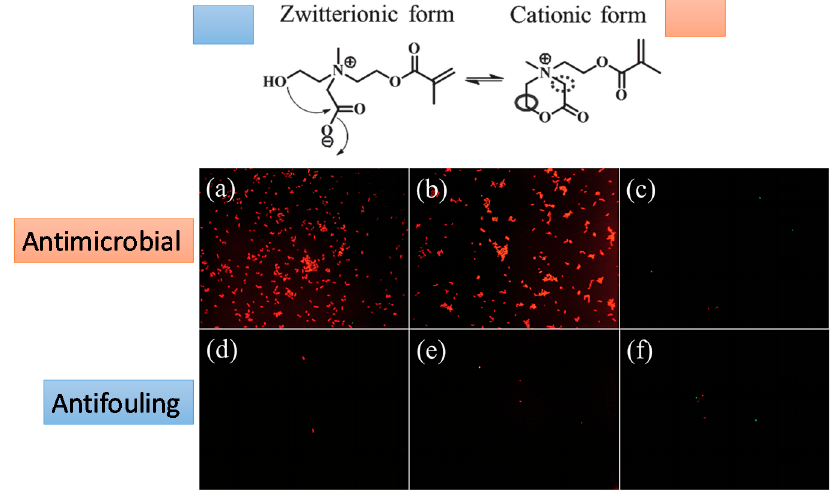
Figure 14. Fluorescence microscopy images of bacterial attachment on pCBOH1 in cationic form ( a ); pCBOH2 in cationic form ( b ); and poly(carboxybetaine methacrylate) pCBMA ( c ) hydrogels before hydrolysis and on pCBOH1 in zwitterionic form ( d ); pCBOH2 in zwitterionic form ( e ); and pCBMA ( f ) hydrogels after 16 h of hydrolysis in PBS. Cells with damaged cytoplasmic membrane are in red, and cells with intact cytoplasm membrane are in green. Reproduced with permission from [40].